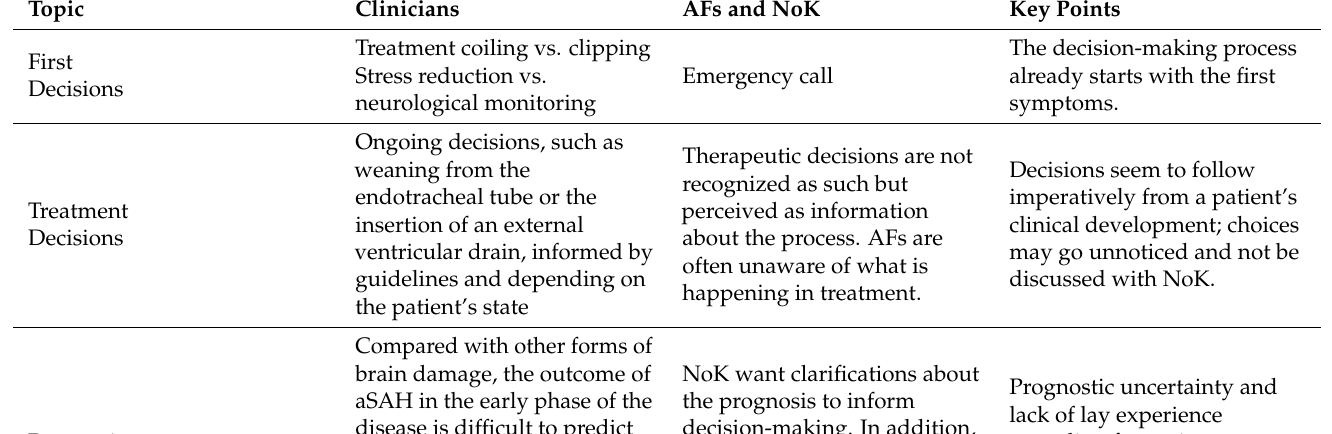
Table 4. Synopsis of decision-making by contrasting two perspectives—clinicians and AFs and their NoK—including key